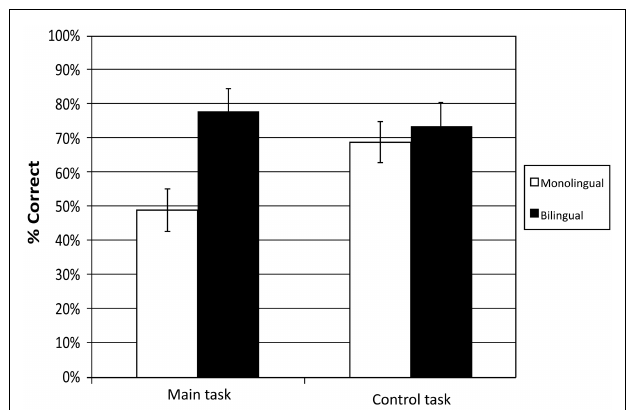
FIGURE 3 | Monolingual and bilingual children’s percent correct on the main task, mapping novel labels to novel properties (left), and on the control task, mapping familiar labels to familiar properties (right) in adjective-mapping tasks.